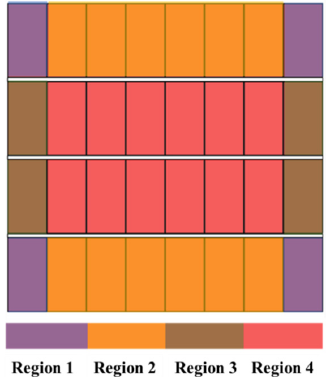
Figure 3. The four regions defined in the battery pack according to